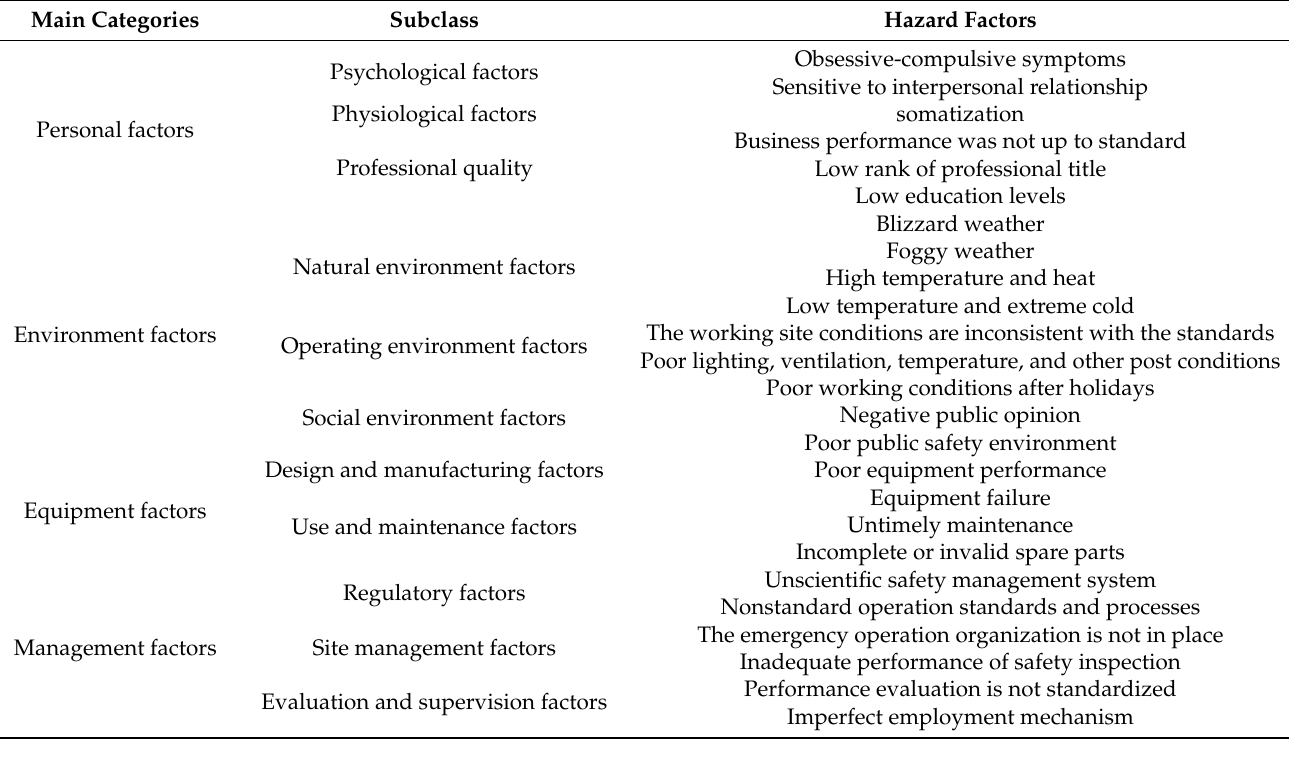
Table 2. Typical hazard factors of the train operation department.